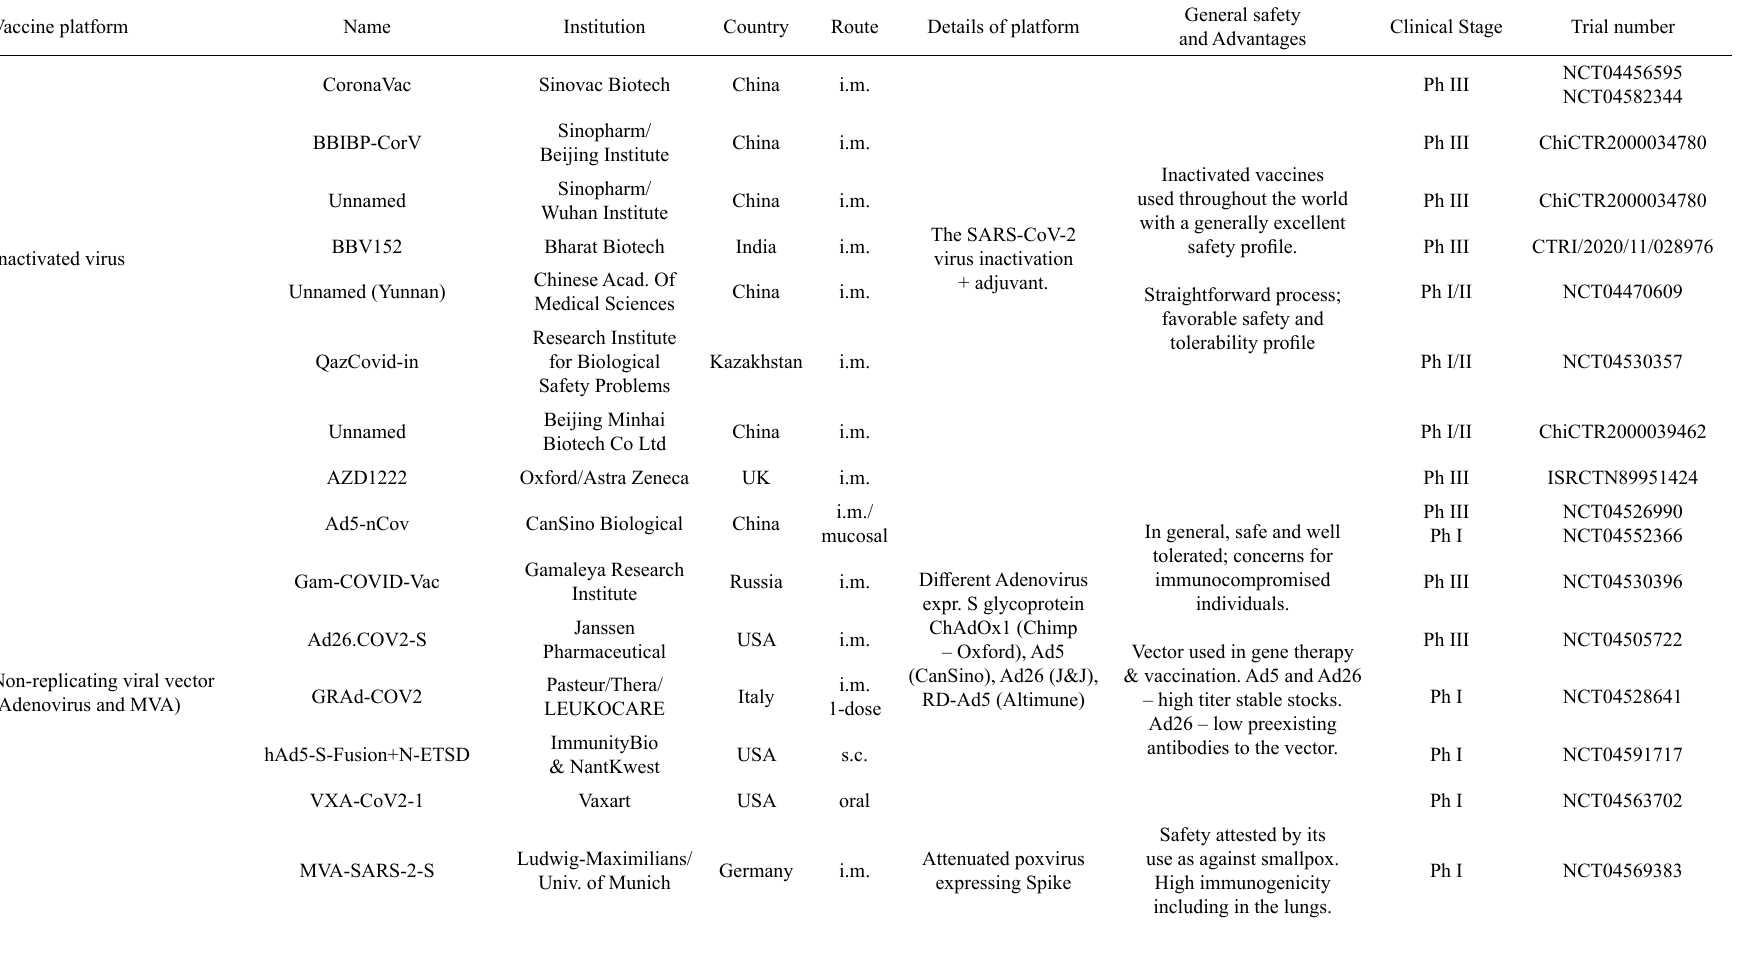
2 Table 1 – Vaccine candidates currently in Clinical